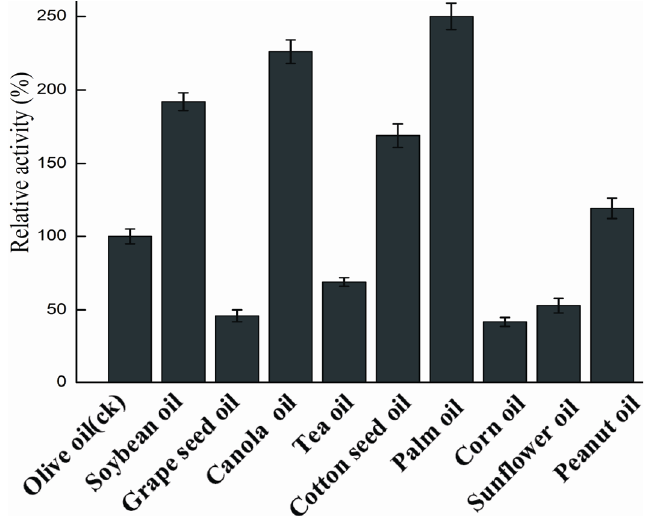
Figure 5. Substrate specificity of rProROL on various oils. Activities on each substrate are expressed as the percentage of that on olive oil. All measurements were carried out in